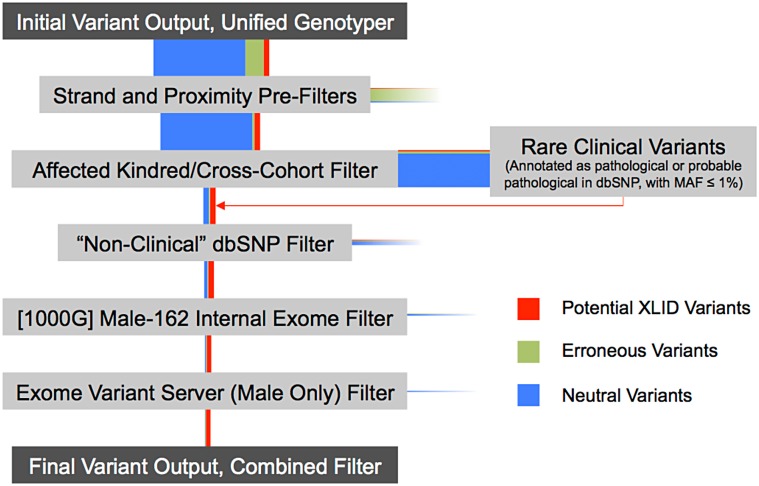
Schematic of Variant Reduction Using a Combined Filter.The Combined Filter sequentially applies all the filters described in this study. Vertical colored bars reflect relative changes in the content of the variant pool after each filter step. Horizontal colored bars reflect rejected variants upon each filter step. The Strand and Proximity Pre-Filters are applied universally. Then the Affected Kindred/Cross-Cohort Filter (with Shared Segment Filter) is applied. The rejected variant pool in this step primarily eliminates neutral variants. Nonetheless, this rejected pool of variants is assessed for co-occurrence with rare dbSNP variants with known pathological function. Rejected variants that positively co-occur in the Rare Clinical Variants dataset are re-introduced (thin red arrow). Database-dependent filters are sequentially applied. Red bars reflect potential XLID variants that may be of functional interest. Green bars reflect variants that are likely sequencing errors. Blue bars reflect variants that are likely neutral in XLID etiology.